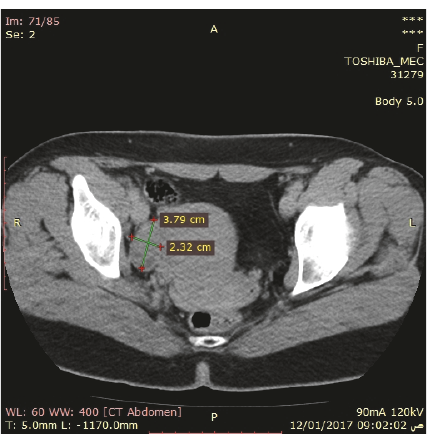
Figure 4: Right ovary measures 3.8 by 2.3 cm.